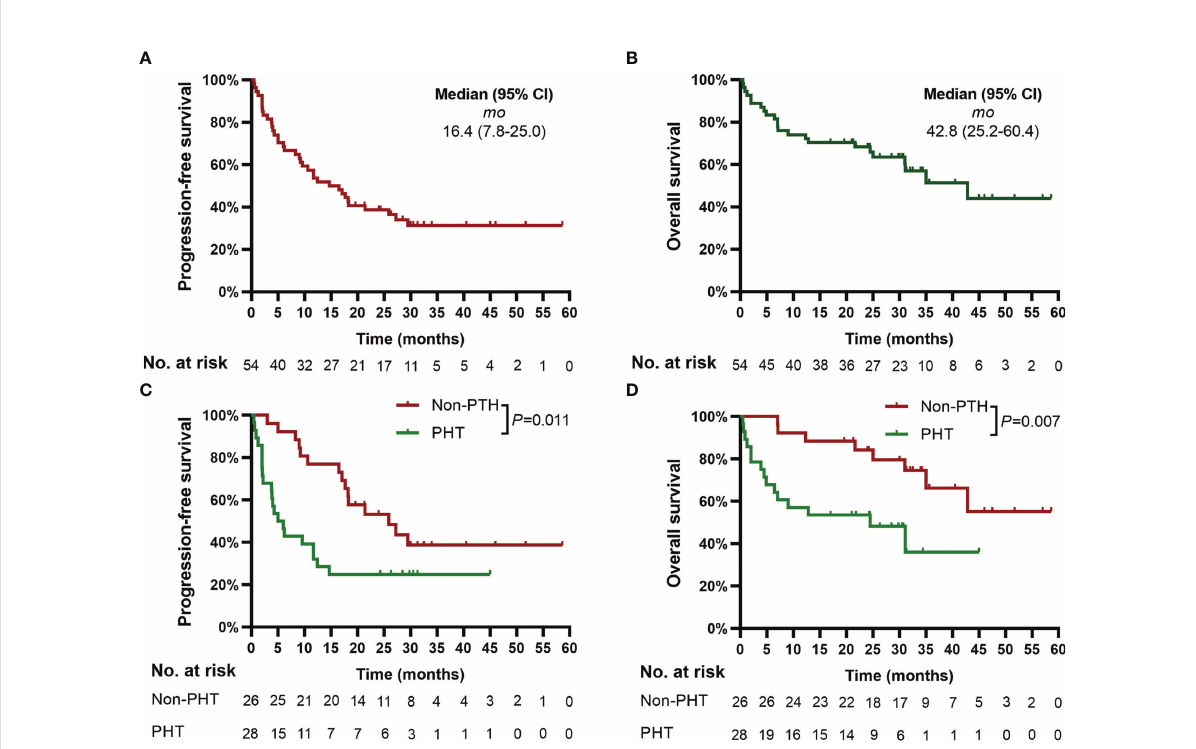
FIGURE 2 Progression-free survival (PFS) and overall survival (OS). Panels (A, B) show the Kaplan − Meier curves for PFS and OS in the 54 patients, respectively. Panels (C, D) show the Kaplan − Meier curves of PFS and OS, respectively, according to PHT. Two-sided P values were calculated based on the log-rank test. PHT, prolonged hematological